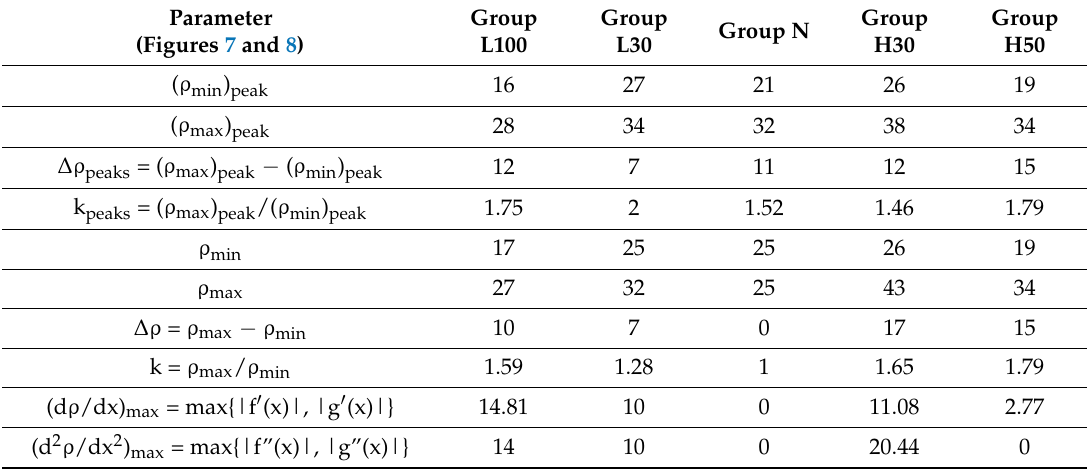
Table 8. Parameters of the reflectivity profiles, graphs, and functions—for metal ceramic dental